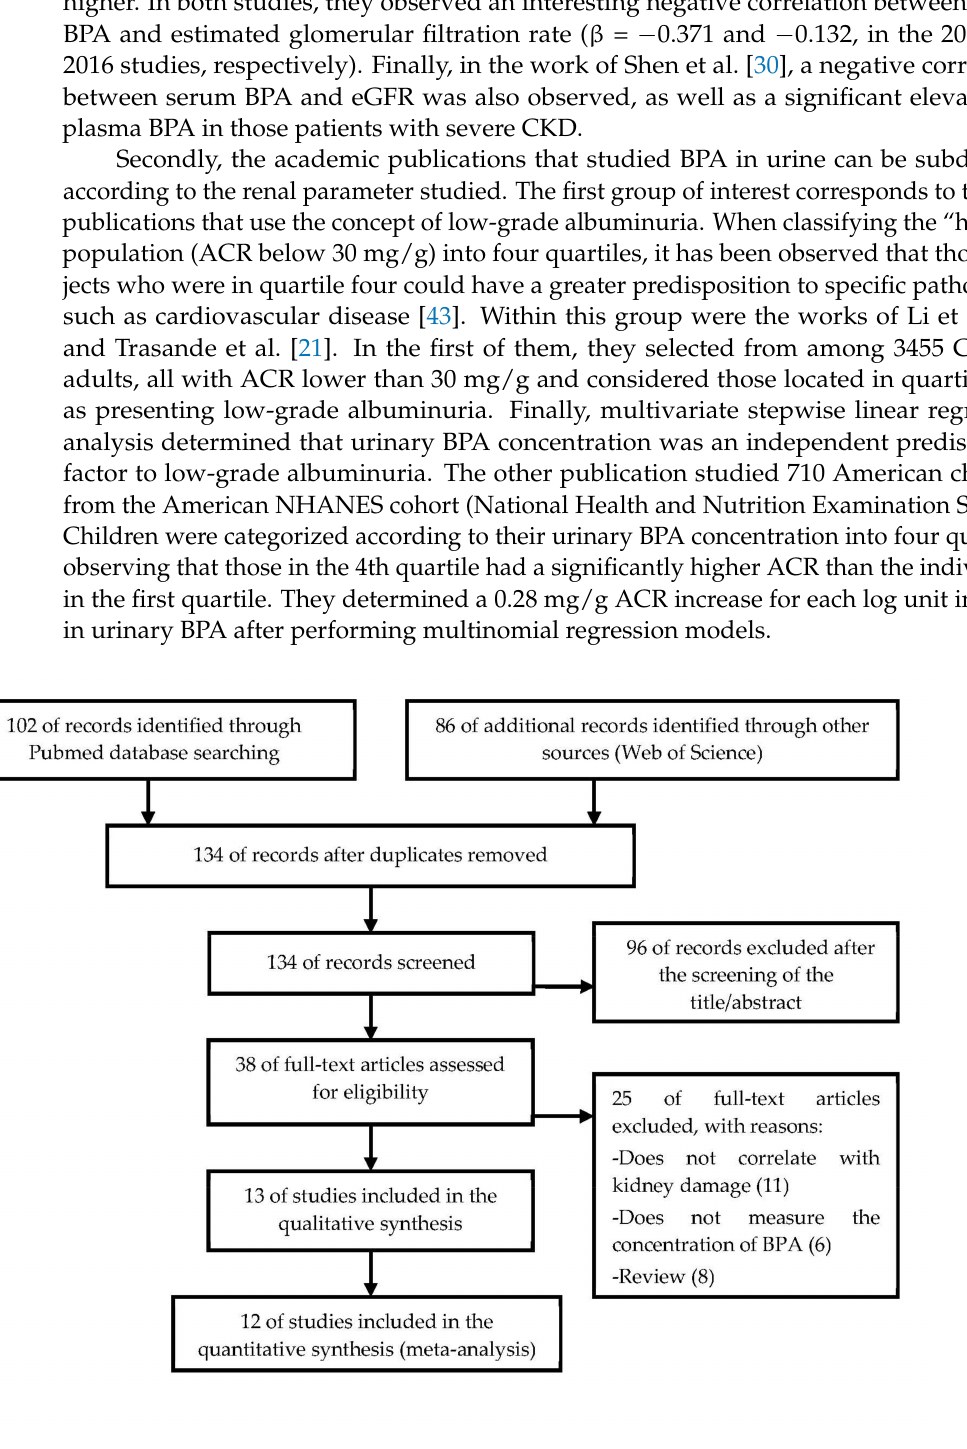
Figure 4. Schematic representation of the methodology used based on The PRISMA Statement